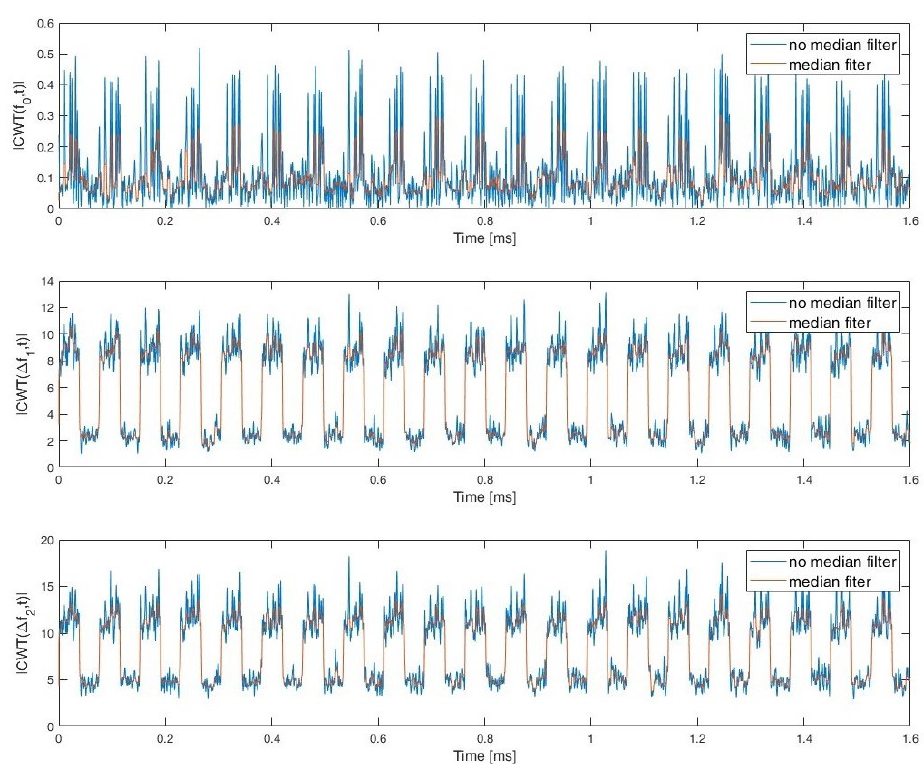
Figure 7. CWT frequency cut for f o ∼ = f c and sum of CWT coefficients range ∆ f 1 and ∆ f 2 . PCPW.